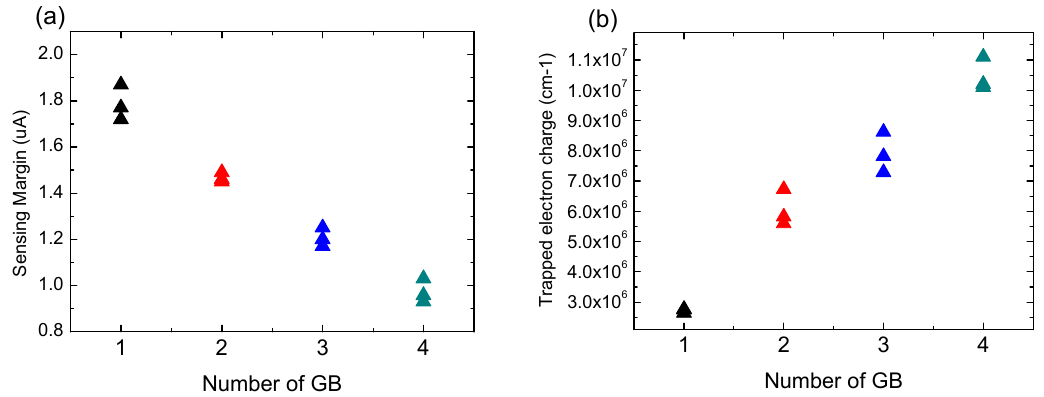
Figure 6. ( a )Sensing margin and ( b ) trapped electron charge according to the number of GBs in the poly ‐ Si channel of poly ‐ Si 1T ‐ DRAM.